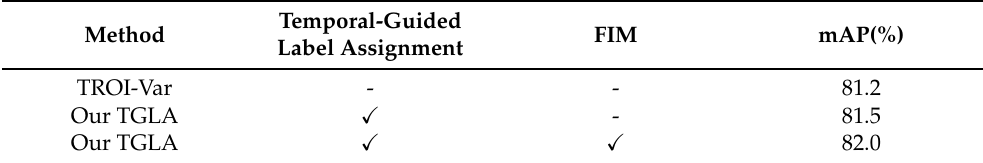
Table 2. The effectiveness of the temporal-guided label assignment framework and feature instructing module. Temporal-guided label assignment is the framework without feature instructing, and FIM is the feature instructing module.